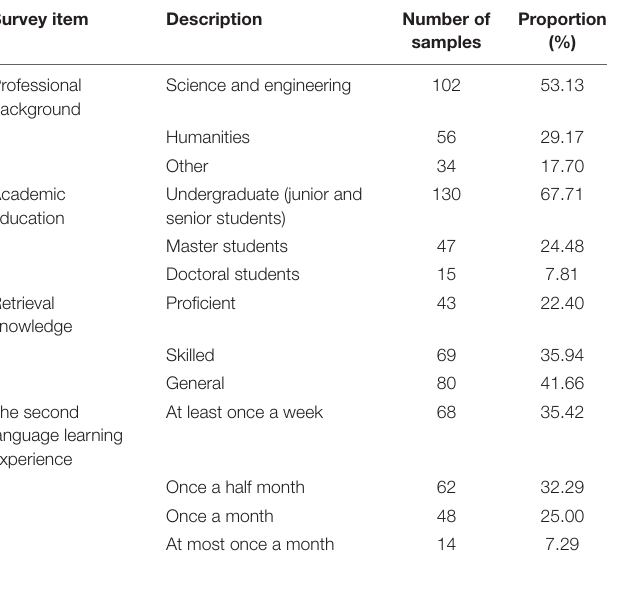
TABLE 1 | Summary of the basic information of the survey objects in the valid questionnaire. Survey item